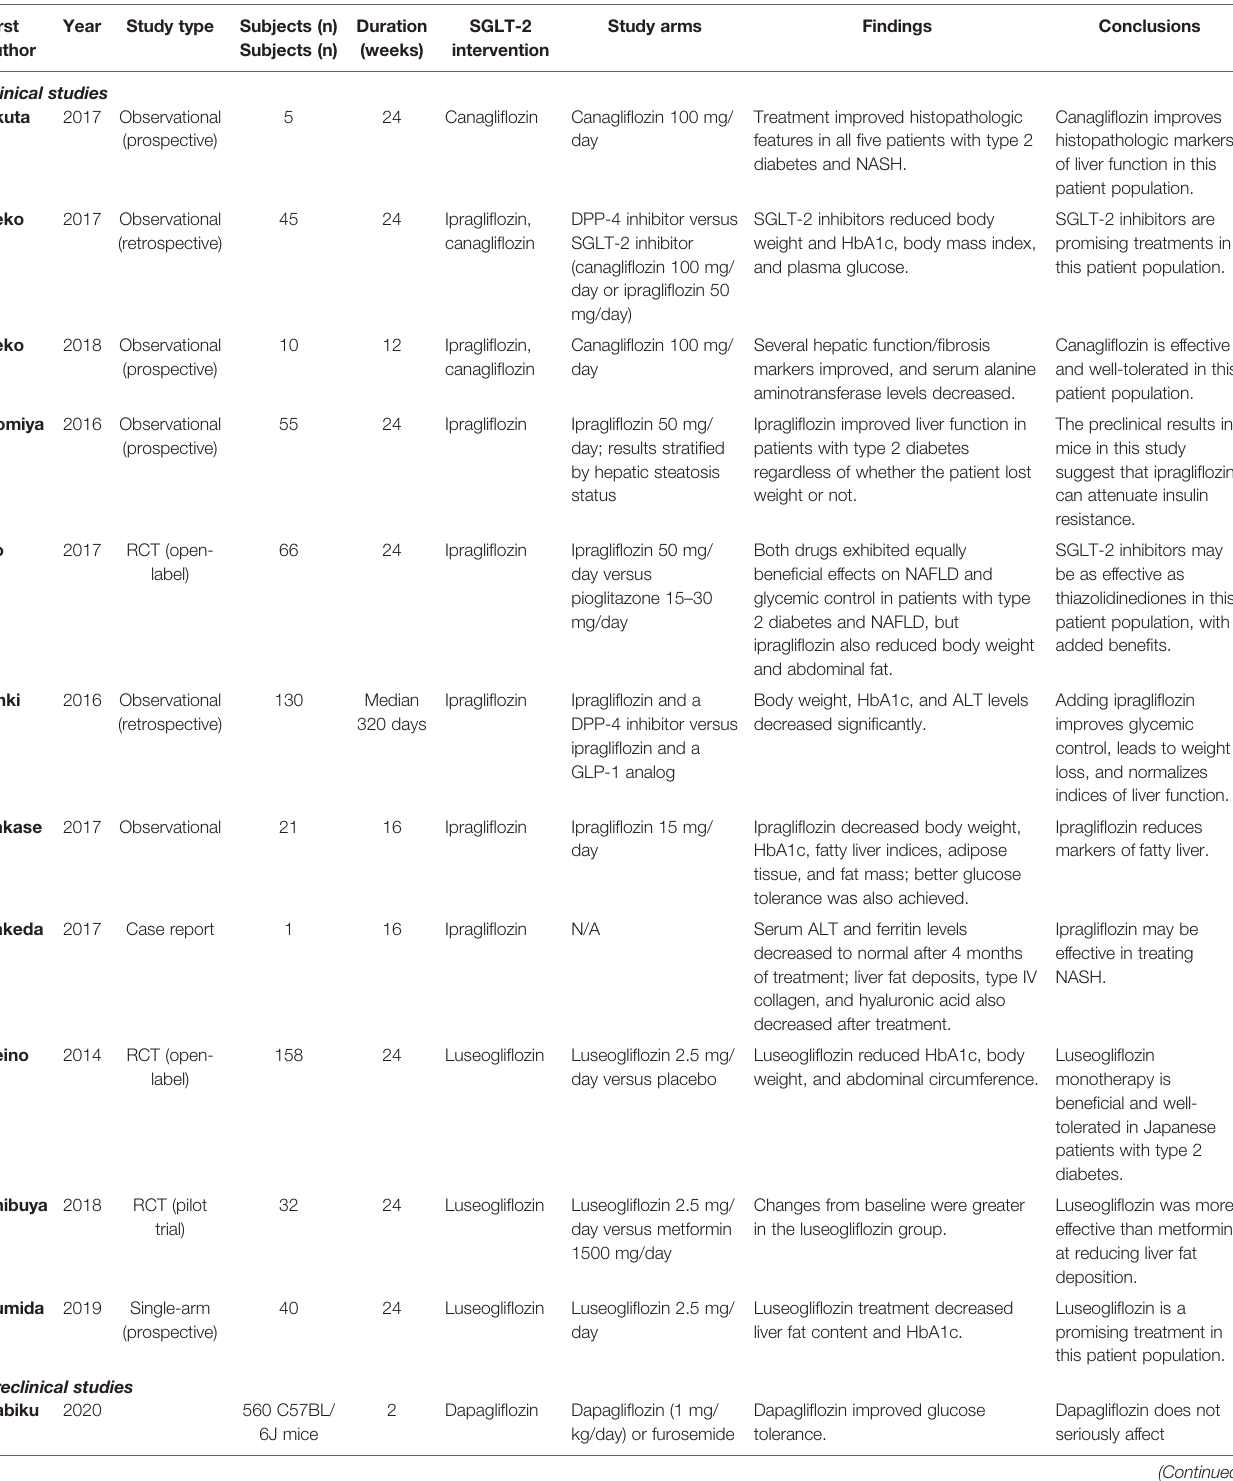
TABLE 3 | Summary of Japanese clinical and preclinical studies of SGLT-2 inhibitors for type 2 diabetes with or without